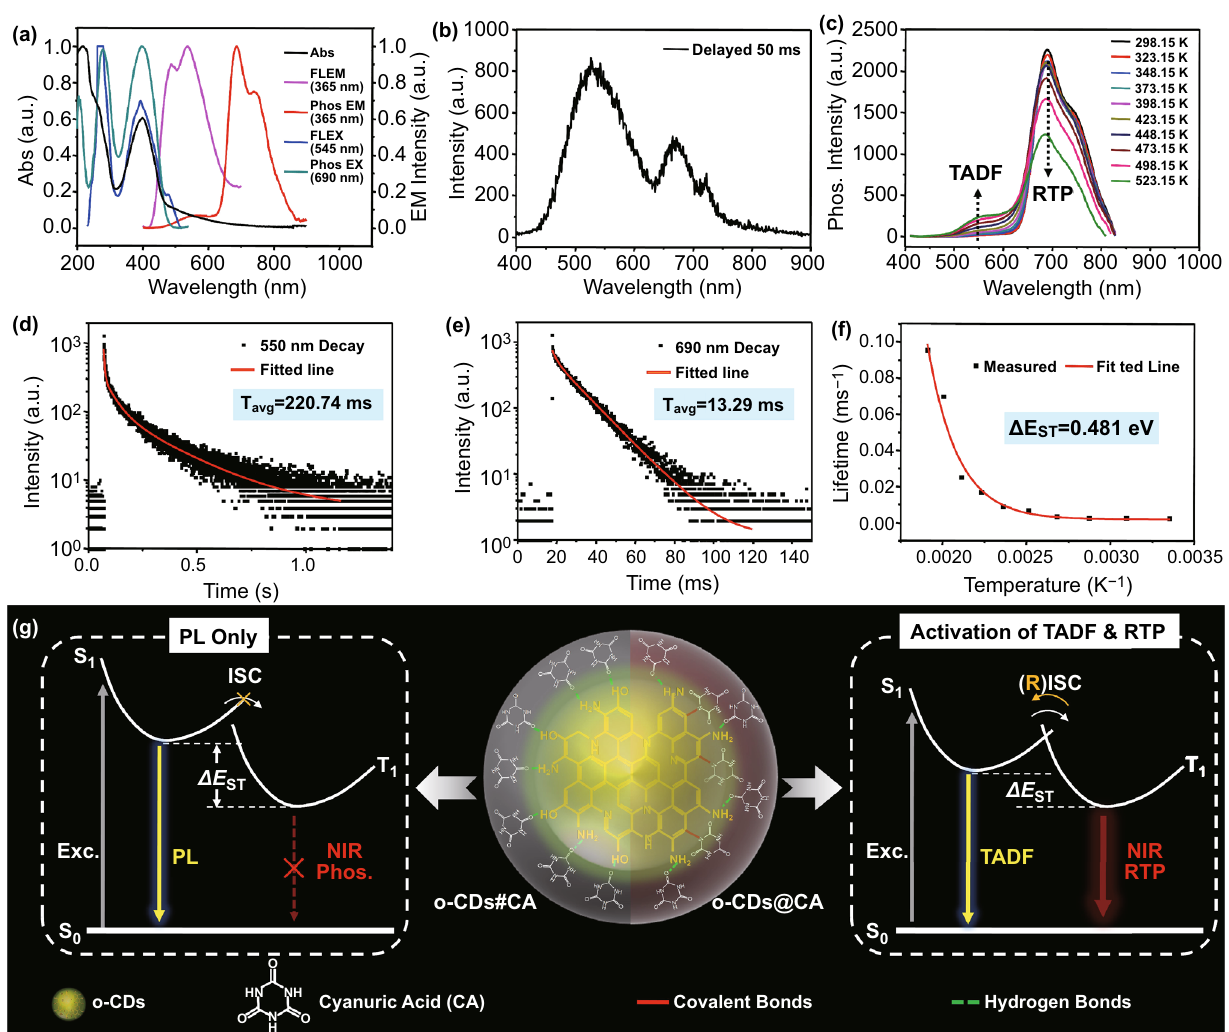
Fig. 3 a Normalized UV–Vis absorption, photoluminescence (PL) emission (λ EX = 365 nm) and excitation (λ EM = 550 nm), and phosphores- cence emission (λ EX = 365 nm) and excitation (λ EM = 690 nm) spectra of o-CDs@CA powder (Abs: absorption; EX/EM: excitation/emission); b afterglow emission spectrum of o-CDs@CA powder with 50 ms delay under the excitation of 365 nm at room temperature; c afterglow emission spectra of o-CDs@CA powder at different temperatures (TADF: thermal activated delayed fluorescence; RTP: room temperature phosphores- cence); d‑e afterglow decay spectra of o-CDs@CA powder monitored at 550 nm and 690 nm upon excitation of 365 nm; f afterglow lifetimes of o-CDs@CA as a function of temperature and fitting curve based on Eq. 2; g schematic illustration of the multiple fixation of o-CDs in CA matrix by covalent bonds, hydrogen bonds and physical confinements; possible emission processes of o-CDs embedded in CA by different strat- egies (Exc: excitation; ISC: intersystem crossing; RISC: reversed intersystem